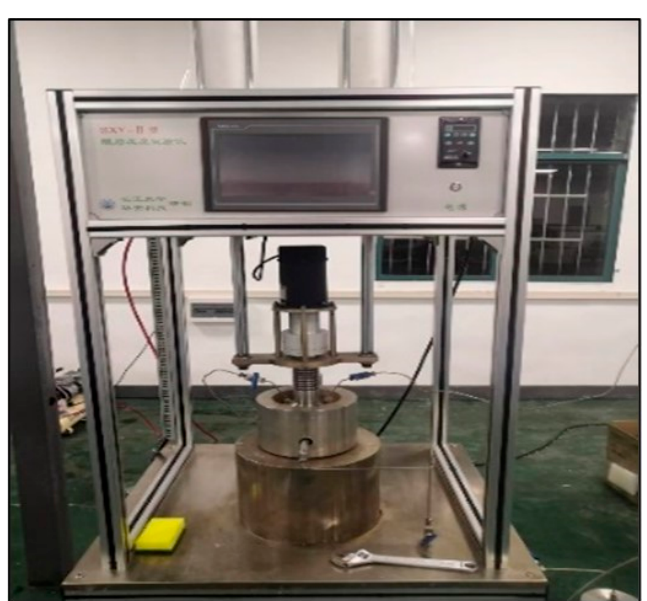
Figure 2. SD-II-type reaction kinetics experimental setup. Table 2. Summary of the influences of various factors on dissolution rate.